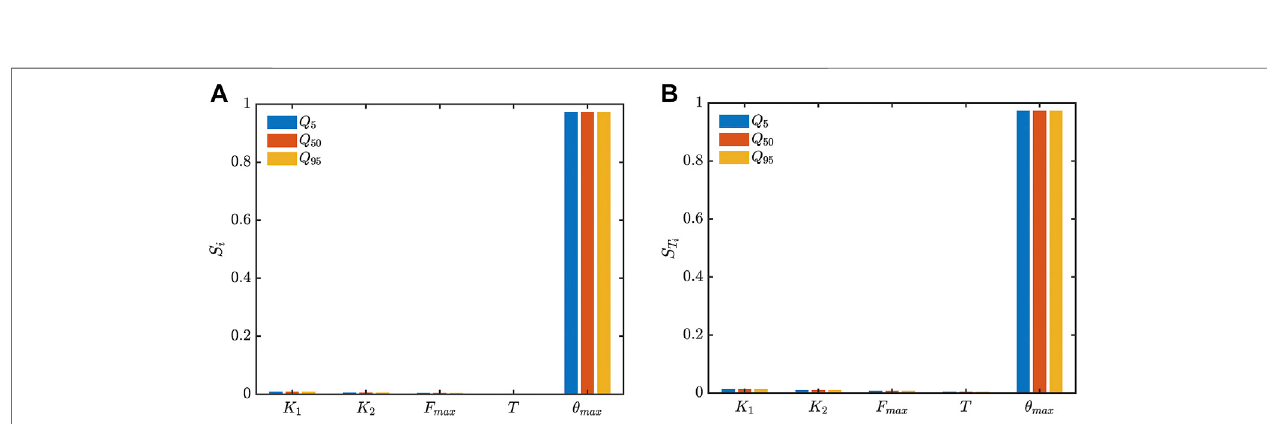
FIGURE 10 | Sobol ’ indices of 5, 50, and 95% quantiles of ^ u L , max : (A) fi rst order and (B) total.